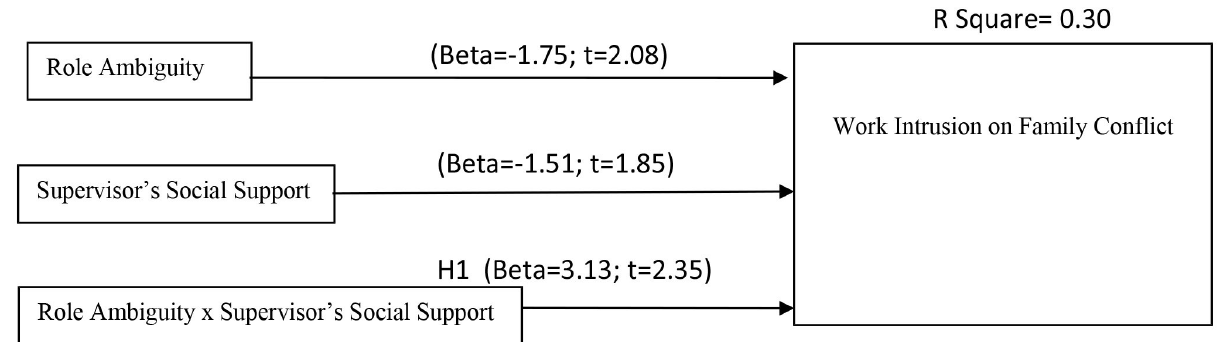
Figure 2. The Results of SmartPLS Path Model Showing the Moderating Effect of Supervisor’s Social Support in Between Role Ambiguity and Work Intrusion on Family Conflict